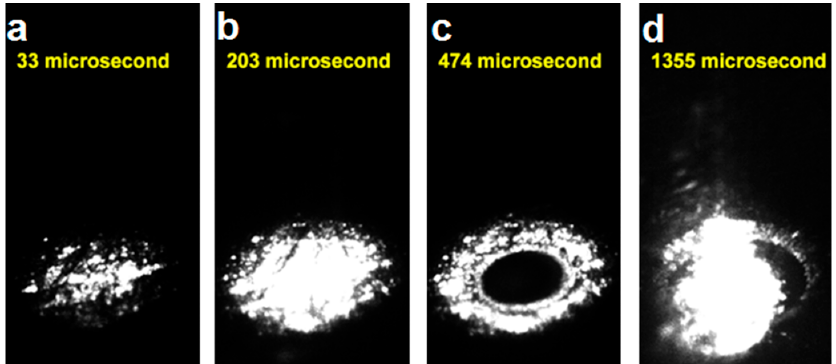
Figure 4. High-speed imaging of AlMg5 surface behavior under the action of a laser pulse of 5.5 kW power and 2 ms duration: ( a ) start of incandescence; ( b ) highest incandescence before melting; ( c ) expansion of the liquid phase starting from the center of the spot; ( d ) liquid expulsion from the molten pool.